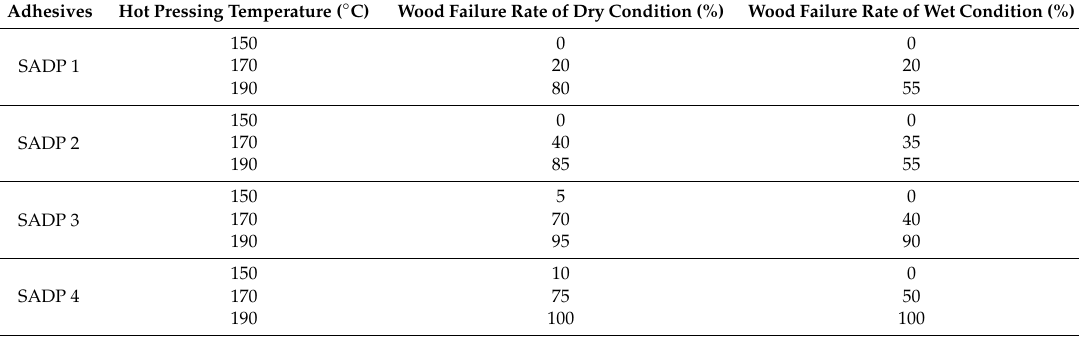
Table 3. Wood failure of the three-ply plywood bonded with SADP adhesives at di ff erent hot pressing temperatures.